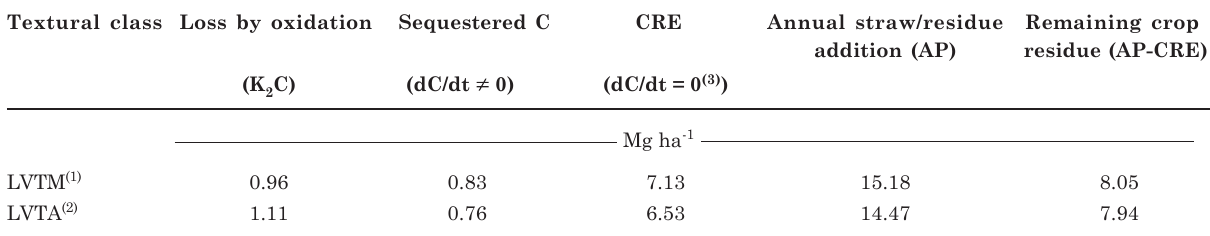
Table 6. Amount of crop residues equivalent (CRE) to maintain the dynamic carbon equilibrium in a Typic Hapludox (Oxisol) with medium texture, and clay texture under a long-term no-till system